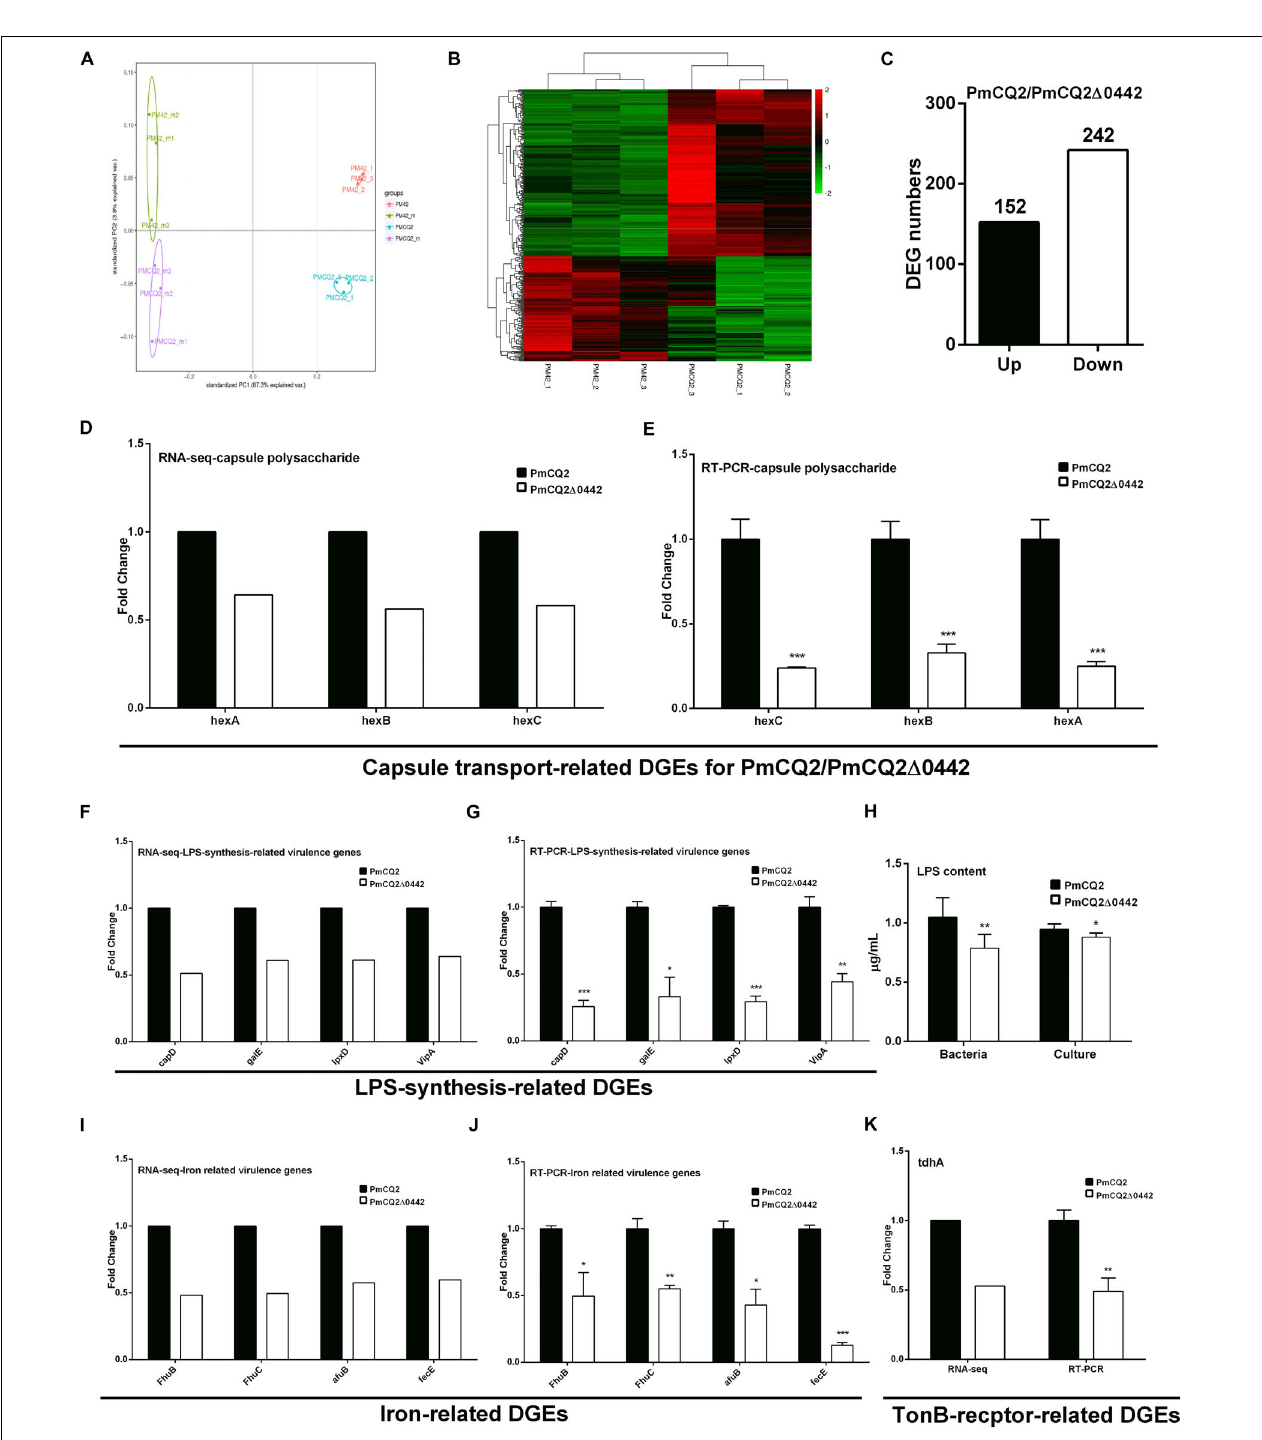
FIGURE 4 | Virulence gene transcription in vitro . (A) Principal component analysis (PCA) of PmCQ2 and PmCQ2 (cid:49) 0442 in vitro and in vivo ( n = 3). (B) Heat map for clustering of differentially expressed genes (DEGs) (FC ≥ 1.5) of PmCQ2 and PmCQ2 (cid:49) 0442 in vitro . (C) The up/down-regulated DEGs (FC ≥ 1.5) of PmCQ2 and PmCQ2 (cid:49) 0442 in vitro . (D,E) Capsular polysaccharide transport-related DEGs (FC ≥ 1.5) in RNA-seq (D) and in RT-PCR ( n = 3) (E) . (F,G) LPS synthesis related DEGs (FC ≥ 1.5) in RNA-seq (F) and in RT-PCR ( n = 3) (G) . (H) Determination of LPS content in PmCQ2, PmCQ2 (cid:49) 0442 and their culture. (I,J) Iron-related DEGs (FC ≥ 1.5) in RNA-seq (I) and in RT-PCR ( n = 3) (J) . (K) TonB-receptor-related DEGs (FC ≥ 1.5) in RNA-seq and in RT-PCR ( n = 3). Panels (E,G,J,K) were pooled from three independent experiments with 3 replicates per group and analyzed with multiple comparative analysis. Panel (H) was pooled from two independent experiments with 8 replicates per group and analyzed by unpaired t -test. All data were expressed as means ± SD (* p < 0.05, ** P < 0.01, *** P < 0.001).